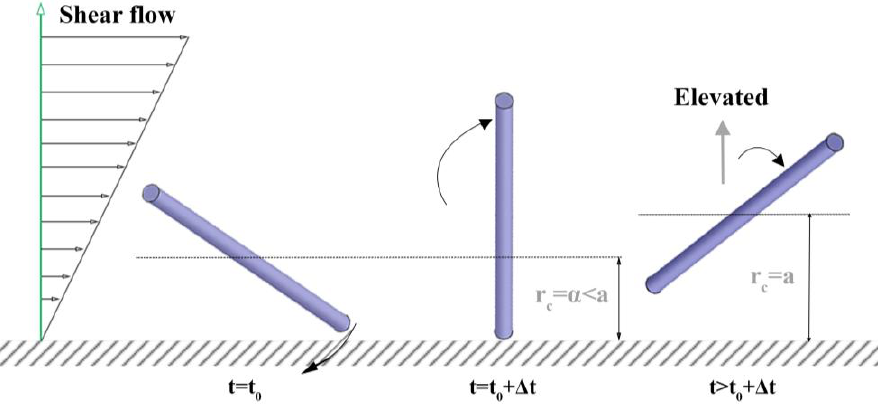
Figure 5. Schematic description for the “shear collision” event and the subsequent “pole-vault motion”. This motion suddenly pushes r c from α to a .